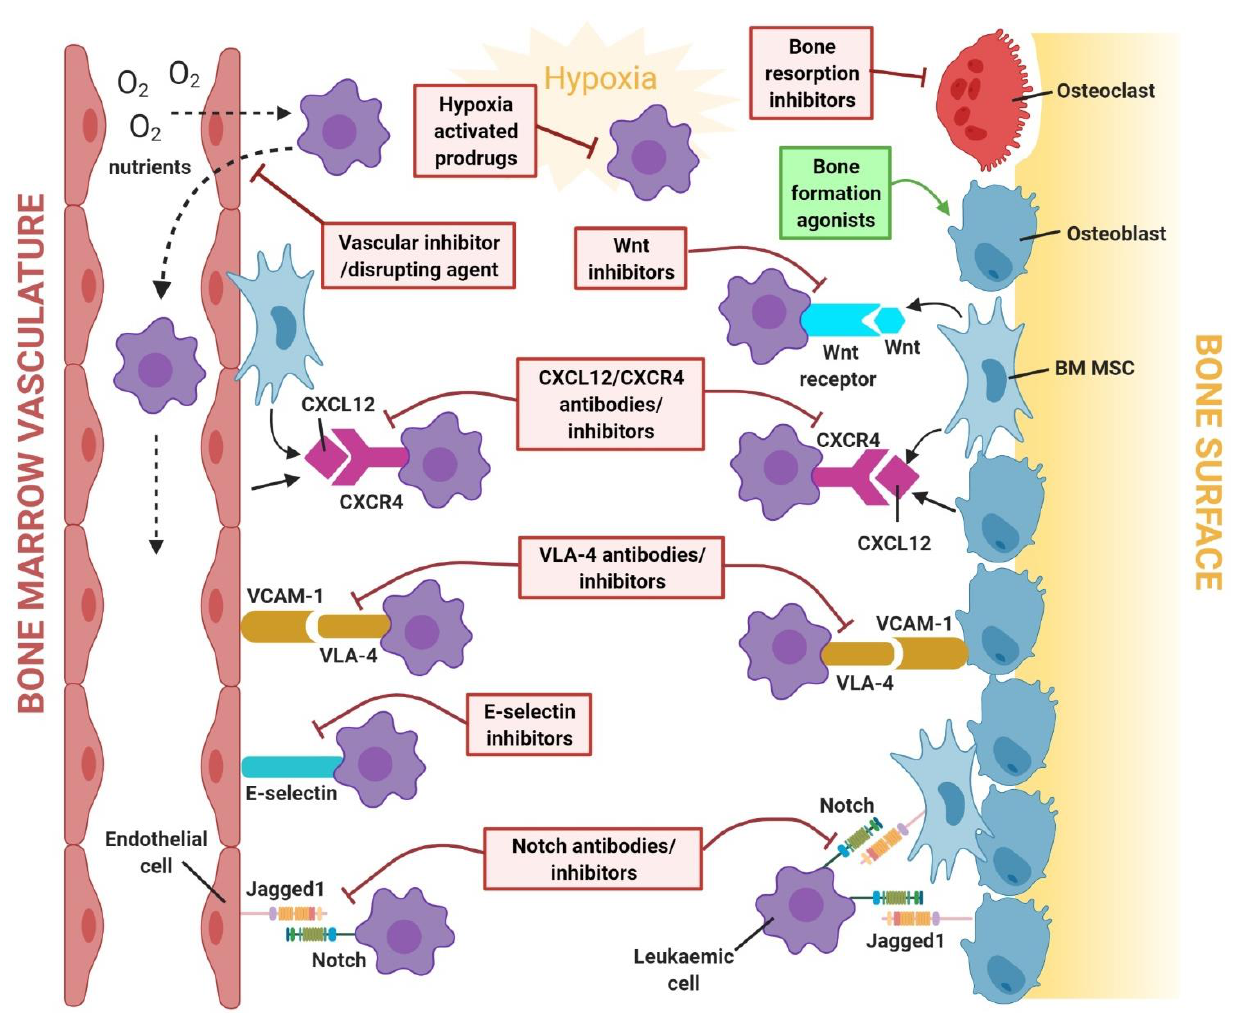
Figure 2. Regulatory and survival pathways targeted by therapeutic agents in the leukaemia bone marrow niche. Thera- peutic agents can block interactions between leukaemic cells and niche cells by interfering with cell adhesion (e.g., VLA- 4/VCAM-1, E-selectin, Notch/Jagged1) and paracrine regulation (e.g., CXCL12/CXCR4, Wnt/ β -catenin). Furthermore, agents that are capable of normalising bone homeostasis (by targeting osteoblast and/or osteoclast activities), as well as targeting tumour-supportive vasculature and the hypoxic environment in the leukaemia niche, show therapeutic poten- tial.